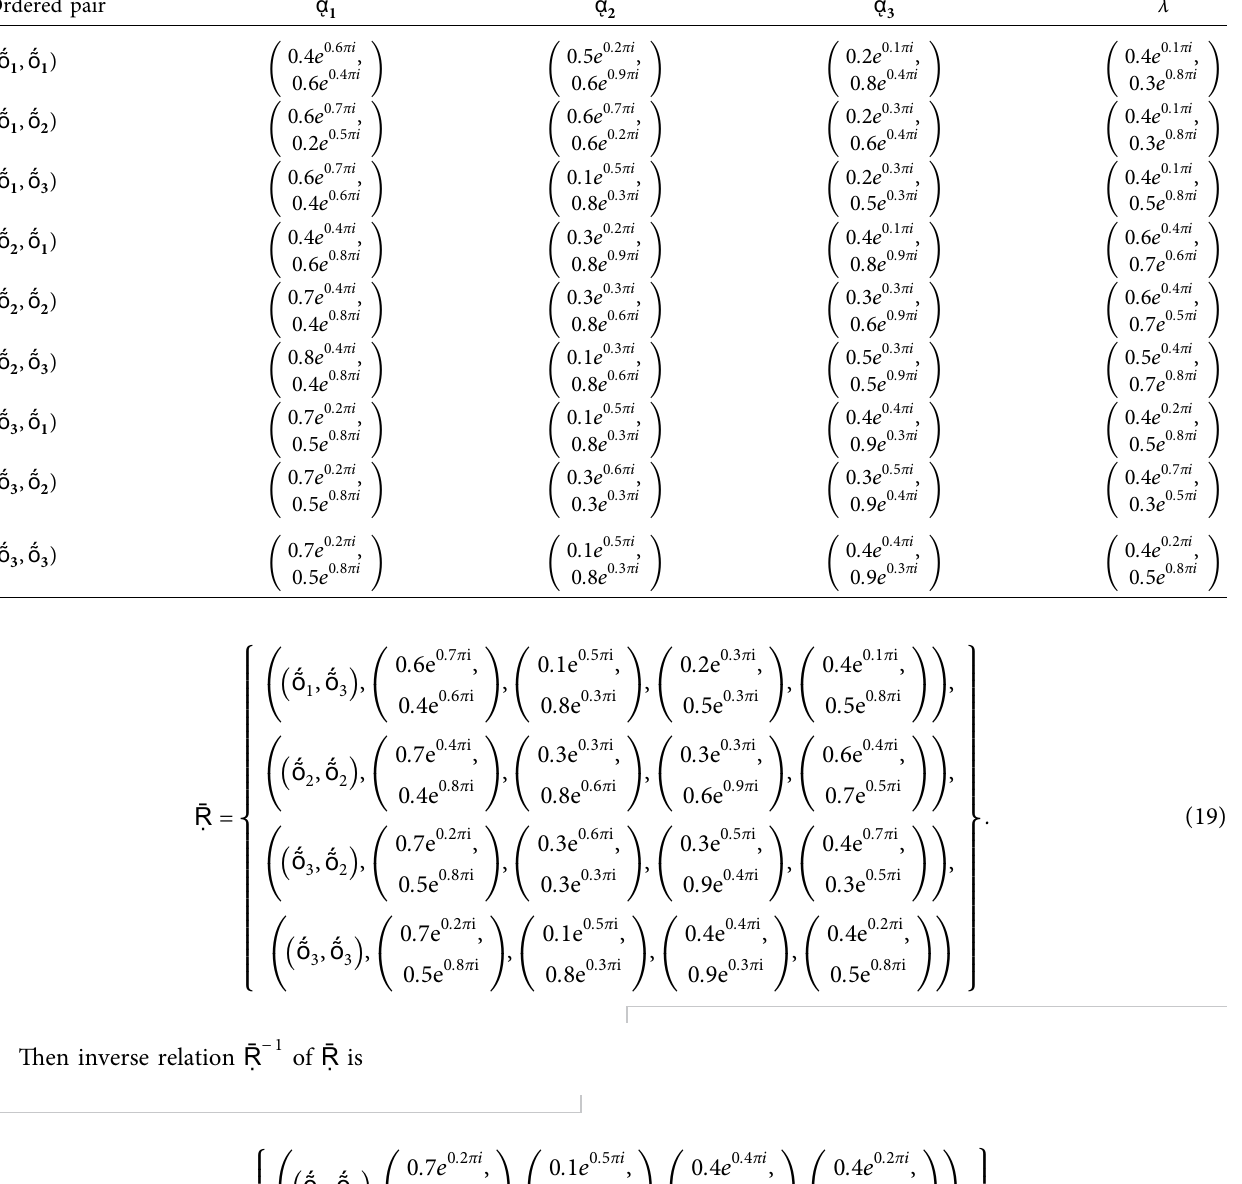
Table 1: Cartesian